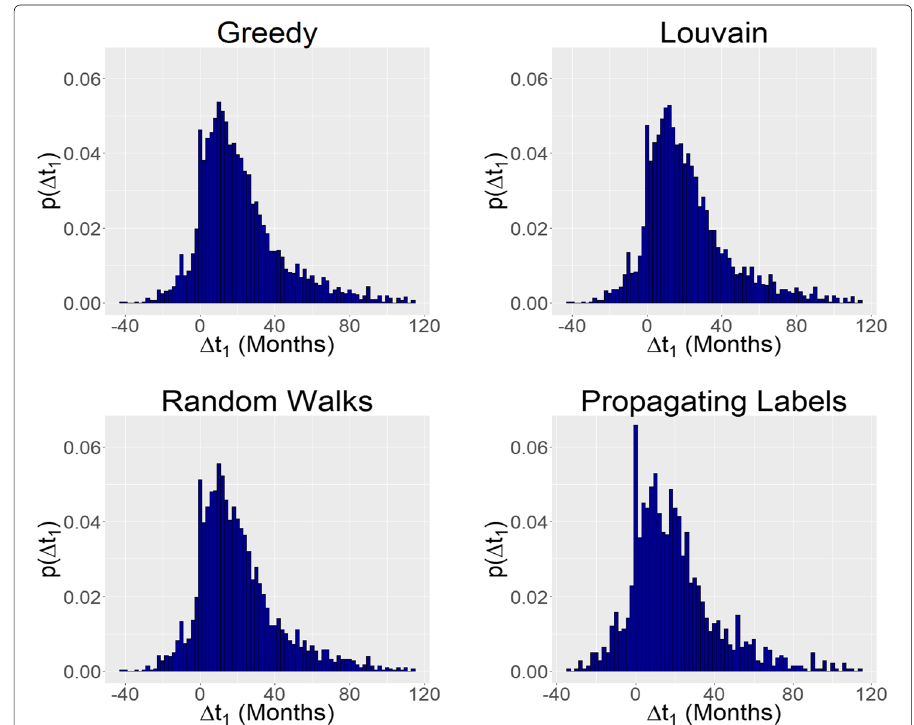
Fig. 4 In-community first-citation time lag distributions for different community structures. The distributions of the time lag (cid:4) t 1 until first citation when this is an in-community citation are shown for the different community structures on the largest connected component of the co-inventor network obtained by the Greedy, Louvain Random-Walks, and Propagating-Labels